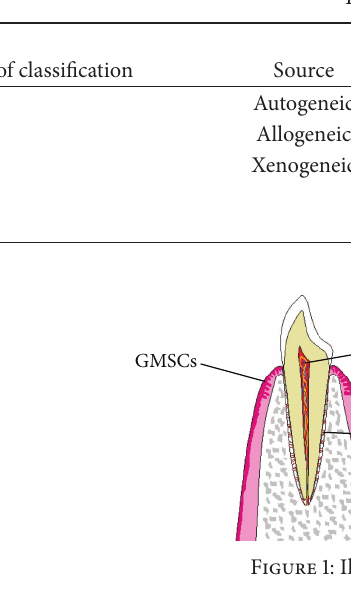
Table 1: Methods of stem cell classification.